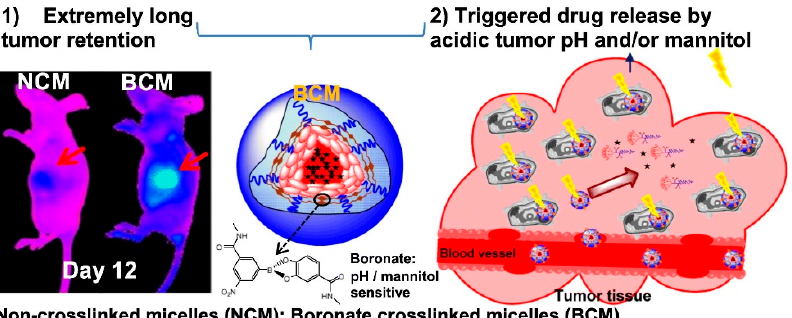
Figure 3. This is schematic illustration of long tumor retention and dual-sensitive boronate cross- linked micelles (BCM) for cancer therapy (reproduced with permission from [74], Copyright 2017 Elsevier). Boronate ester bonds formed between boronic acids and cis-diol catechols (such as mannitol) are responsive to pH and/or mannitol. Near-infrared fluorescence imaging (excitation = 625 nm, emission = 700 nm) was used for visualization of drugs in vivo.